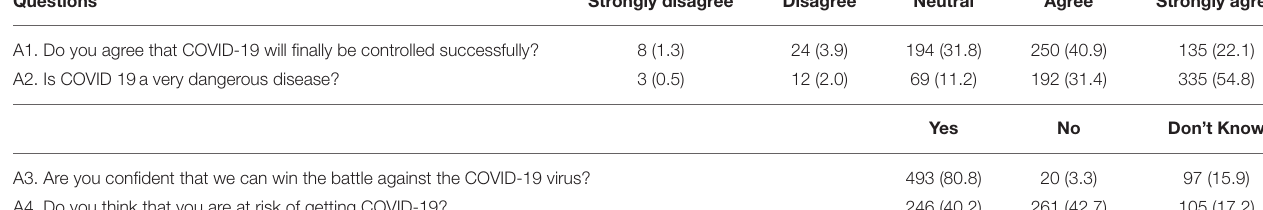
TABLE 3 | Distribution of good knowledge, attitude, and practice based on the demographic characteristics of the participants. Questions